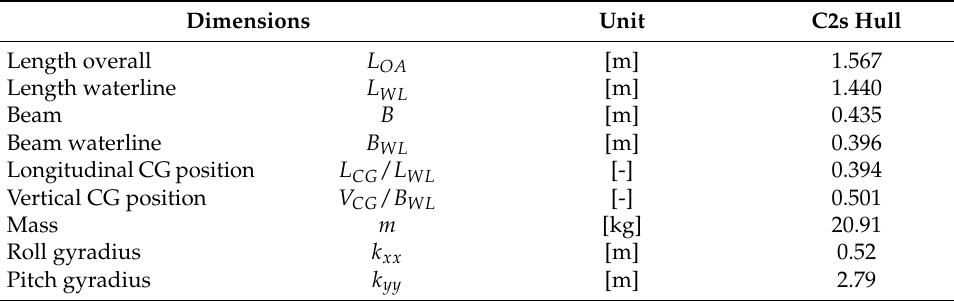
Figure 1. Scheme of the experimental setup. Table 1. Dimension of the C2s hull